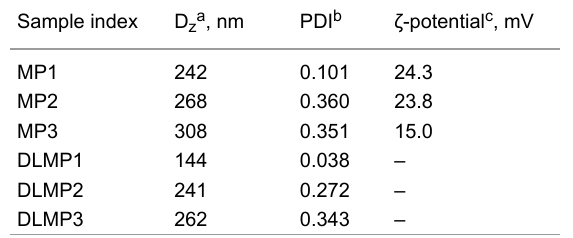
Table 1: Physicochemical characteristics of MP1, MP2, and MP3 and LND-loaded micelles at 25 ºC in aqueous solution.